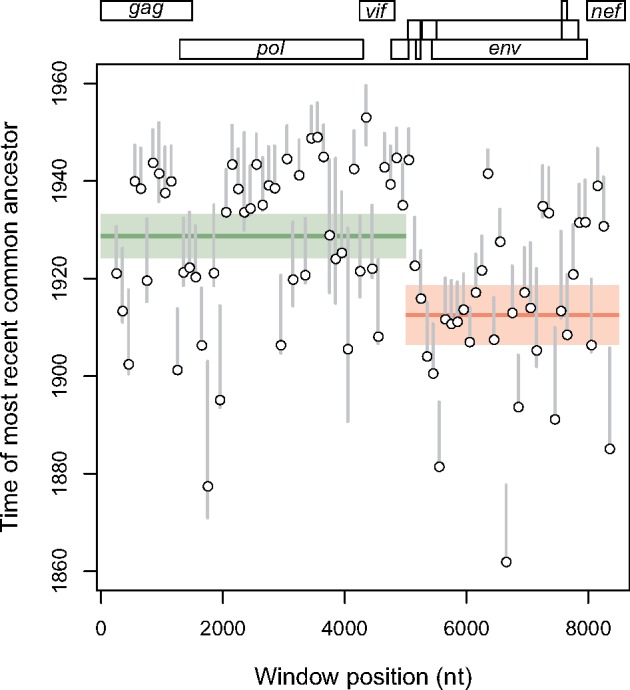
 Origin of HIV-1/M based on LSD. The y-axis represents the estimated root dates (tMRCAs) for sequences in each window. The x-axis represents the genomic coordinates with each position corresponding to a gene region on the HIV-1 genome map at the top of the plot region. Each point represents data for a sliding window of 500 nt per sequence. The gray lines represent the 95% CI for each date estimate. The green and red lines indicate the breakpoint fragments computed using a piecewise linear regression model.